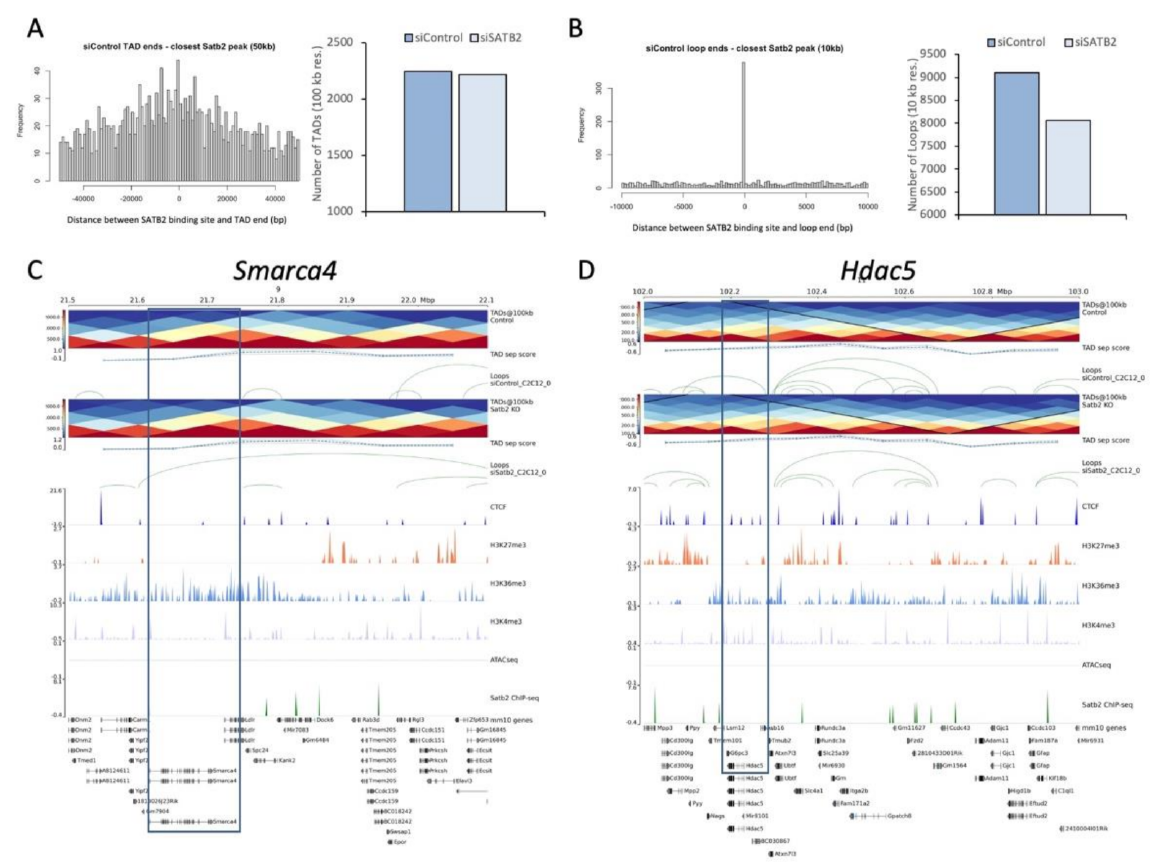
Figure 4. SATB2 is associated with chromatin loops and regulates loop dynamics in a subset of myogenesis-related genes. ( A ) Distribution of SATB2 binding sites with respect to TAD ends (50 kb resolution), as determined by Juicer v.1.6. The bar graph depicts the number of TADs detected at 100 kb resolution between siControl- and siSATB2-treated proliferating C2C12 samples. ( B ) Distri- bution of SATB2 binding sites with respect to loop ends (10 kb resolution), as determined by Juicer v.1.6. The bar graph depicts the number of loops detected at this resolution between siControl- and siSATB2-treated samples. ( C ) Chromatin structural landscape around the Smarca4 locus. TADs and loops were assessed at 100 and 10 kb resolutions, respectively, using the tools described in ( A , B ). CTCF binding motifs were obtained from CTCF ChIP-seq data in mouse C2C12 cells from ENCODE (ENCSR000AIJ). The location of repressive (H3K27me3) and permissive (H3K4me3 and H3K36me3) histone marks were obtained by Asp et al. [35] from proliferating C2C12 myoblasts. The accession numbers for the associated ChIP-seq data are: H3K4me3 (GEO accession: GSM721292), H3K27me3 (GEO accession: GSM721294), and H3K36me3 (GEO accession: GSM721296). ( D ) Chromatin struc- tural landscape around the Hdac5 locus. The structural aspects depicted in the panel were obtained as described